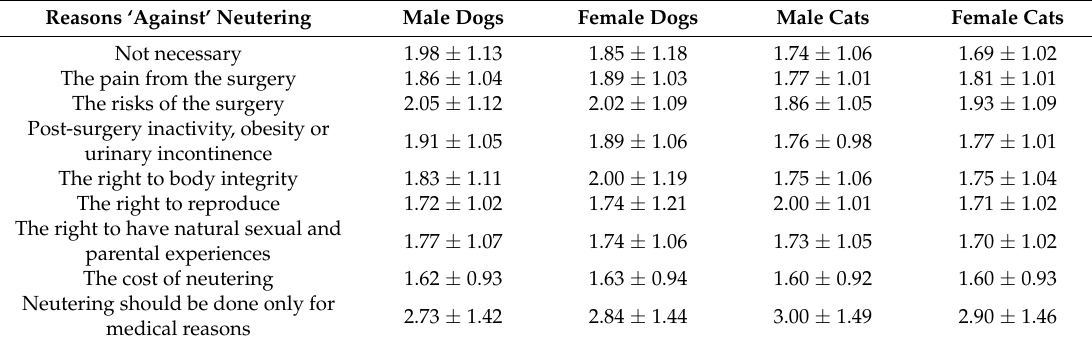
Table 3. Mean ( ± SD) agreement scores (based on assigning strongly disagree = 1; disagree = 2; neutral = 3; agree = 4; strongly agree = 5) for each statement opposing the routine neutering of each animal category from all participants (n =